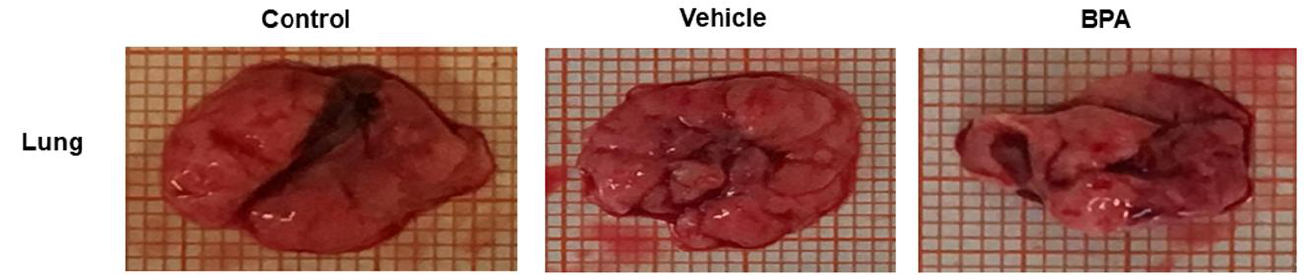
Figure 3. Macro metastasis at the pulmonary level. Representative images of the macro metastasis (tissue lesions) identified in the lungs belonging to the control, vehicle, and BPA-treated groups; millimetric grid as the background.